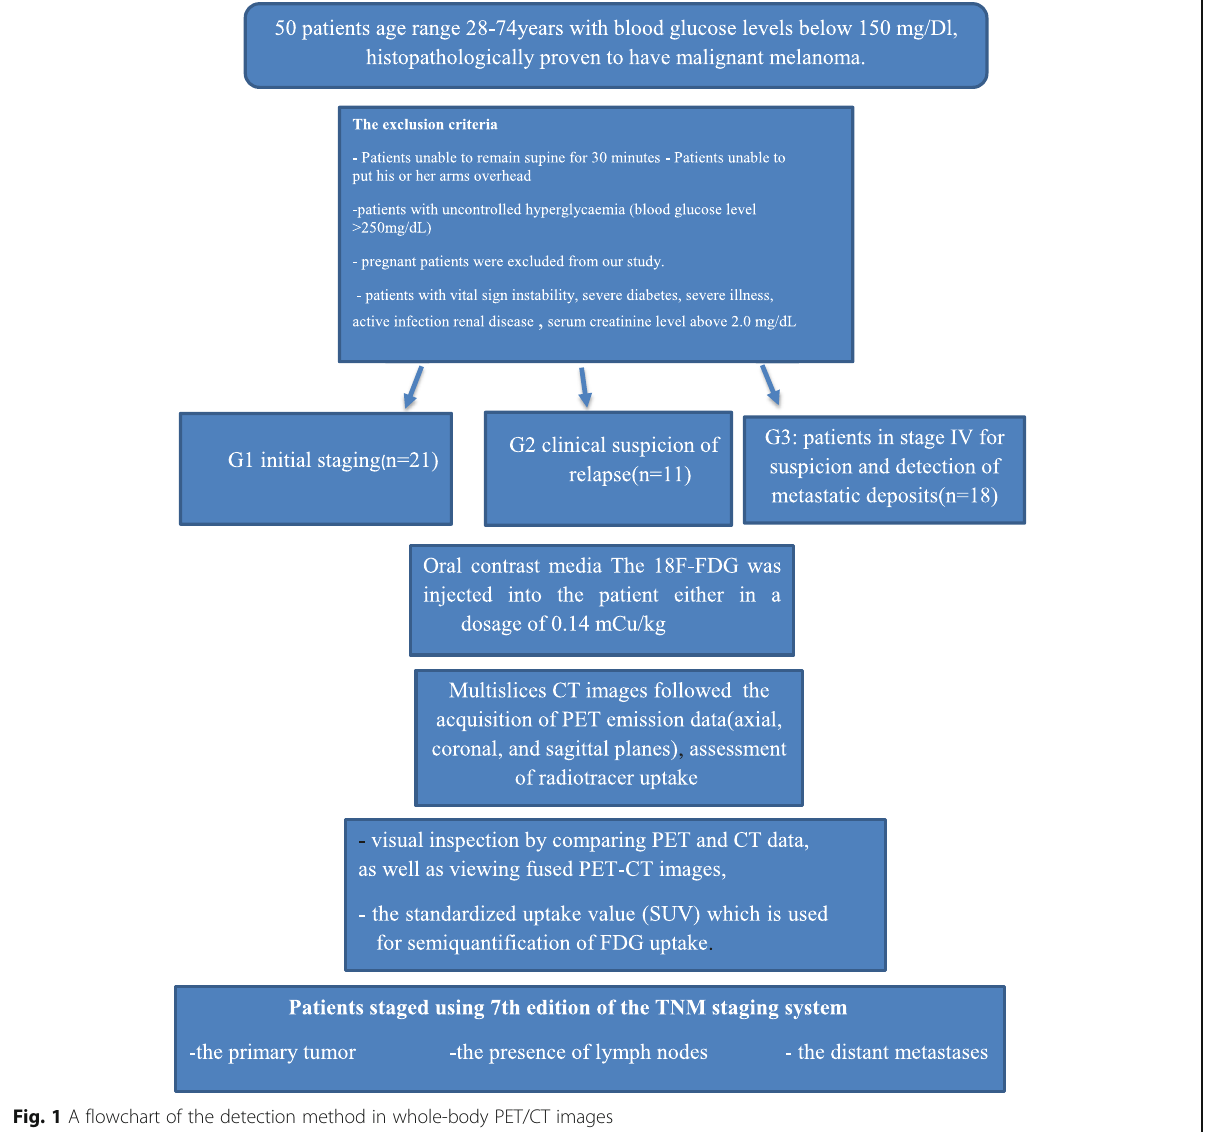
Fig. 1 A flowchart of the detection method in whole-body PET/CT